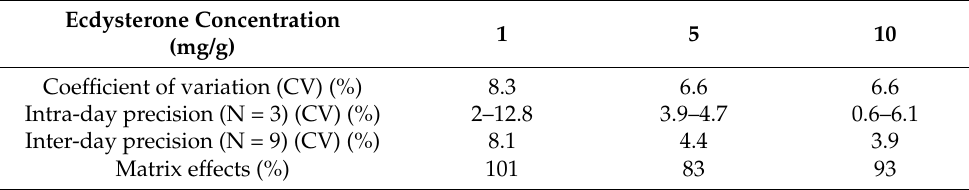
Table 3. Results for validation parameters for concentrations 1 mg/g, 5 mg/g, and 10 mg/g of